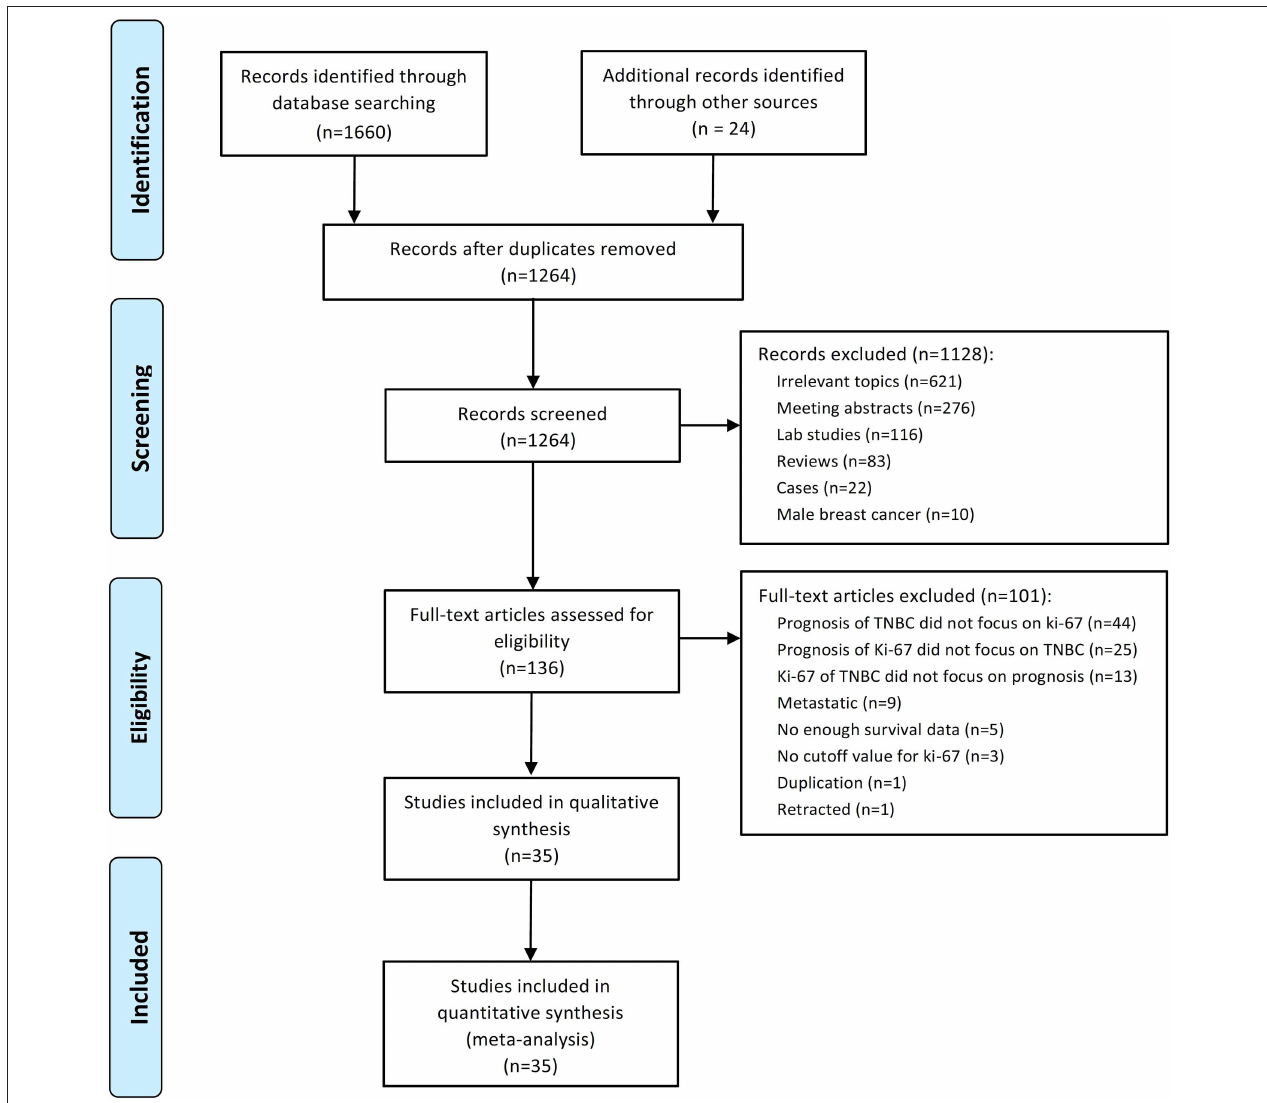
FIGURE 1 | Flow chart of the included